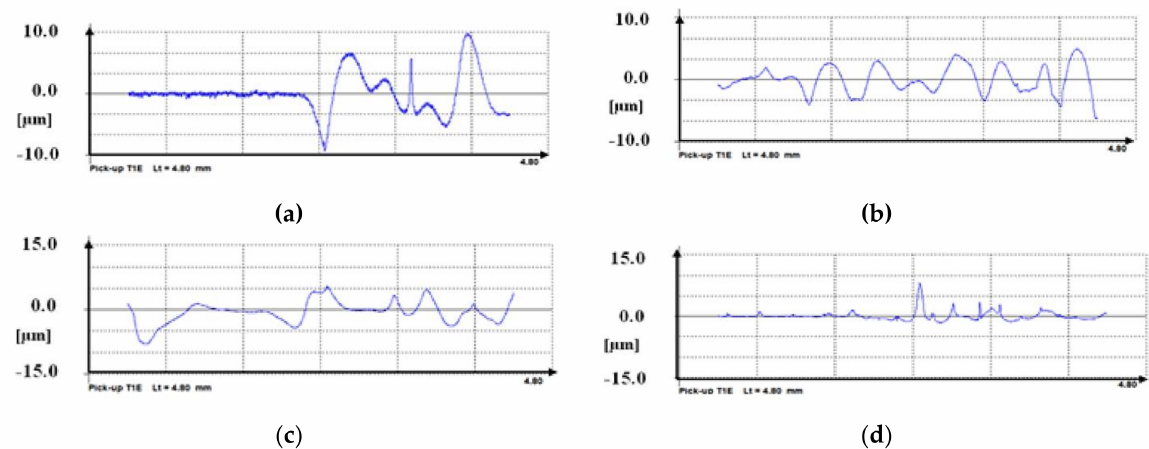
Figure 3. Roughness measurement Ra for coatings deposited on X20Cr13 steel: VTMS/EtOH/AcOH ( a ), VTMS/EtOH/ LiClO 4 ( b ), VTMS/EtOH/H 2 SO 4 ( c ), VTMS/EtOH/NH 3 ( d ). Profilometer Hommel Tester